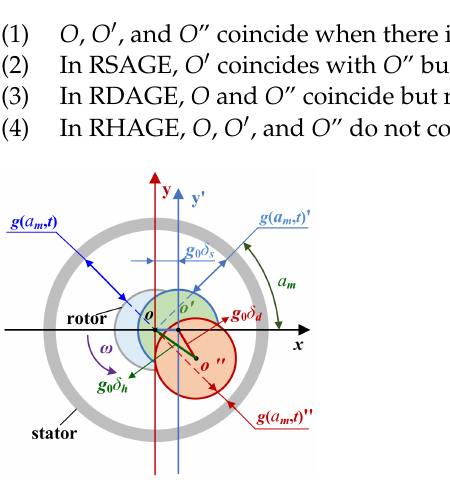
Figure 1. Air-gap under the generator is RAGE.